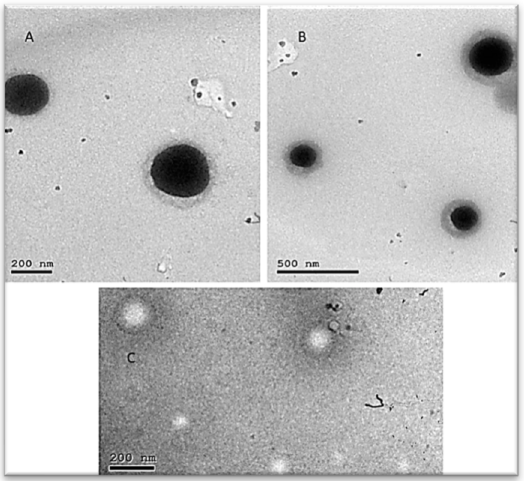
Figure 5. TEM of D-SNESNS ( A , B ): NENS formed by diluting D-SNESNS with distilled water showing spherical ( C ) nanoemulsion globules formed by dilution of SNEDDS with water.